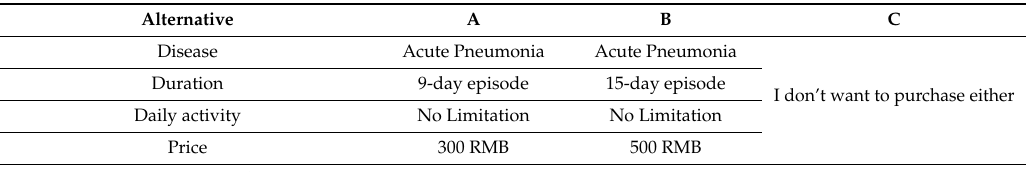
Table A1. Choice set